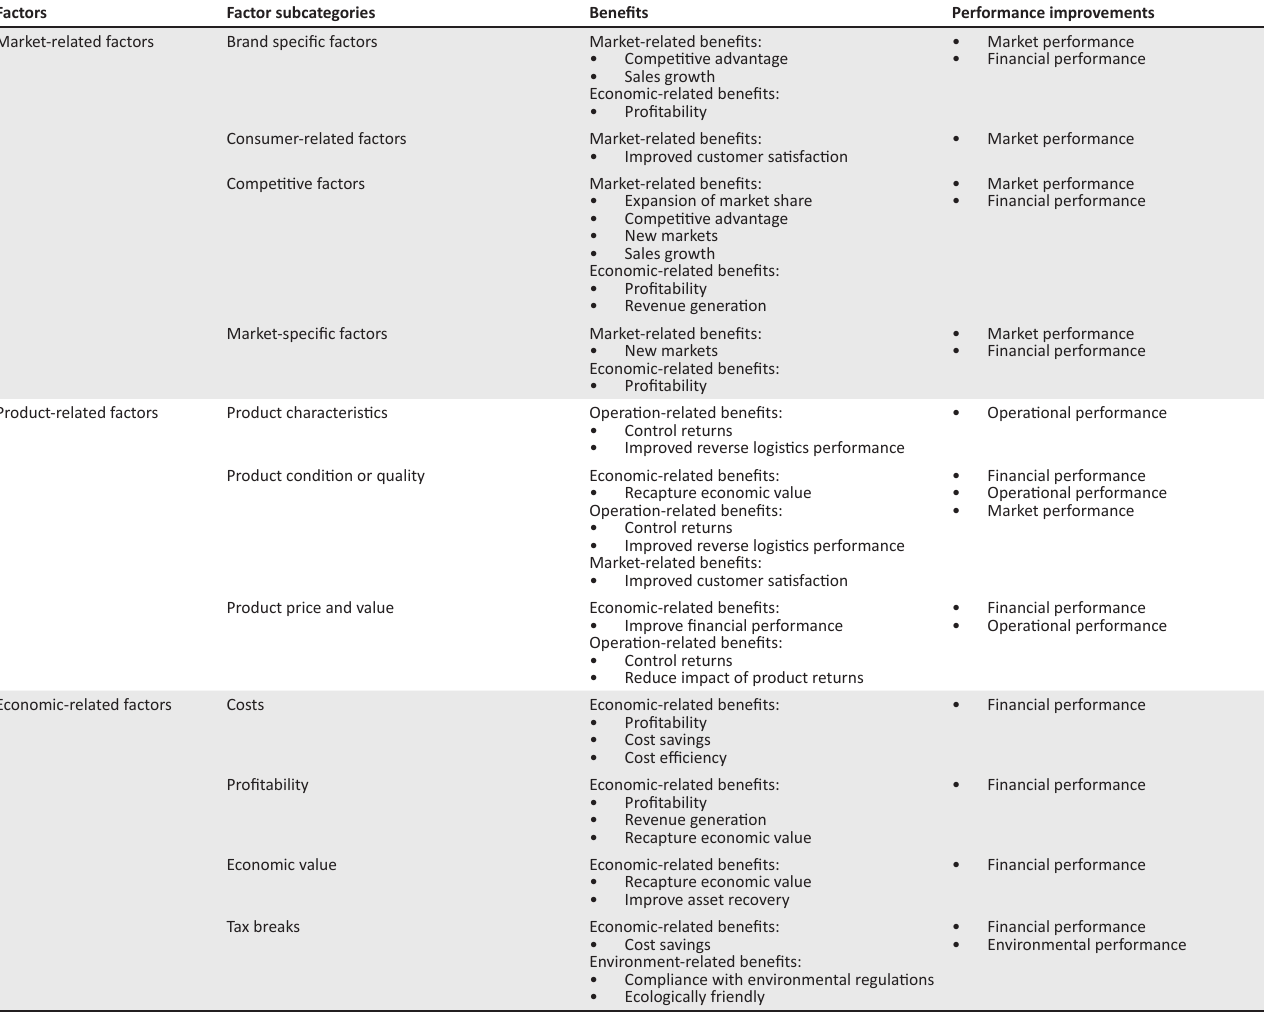
TABLE 4: Conceptual framework of the impact of disposition decision factors on organisational performance.